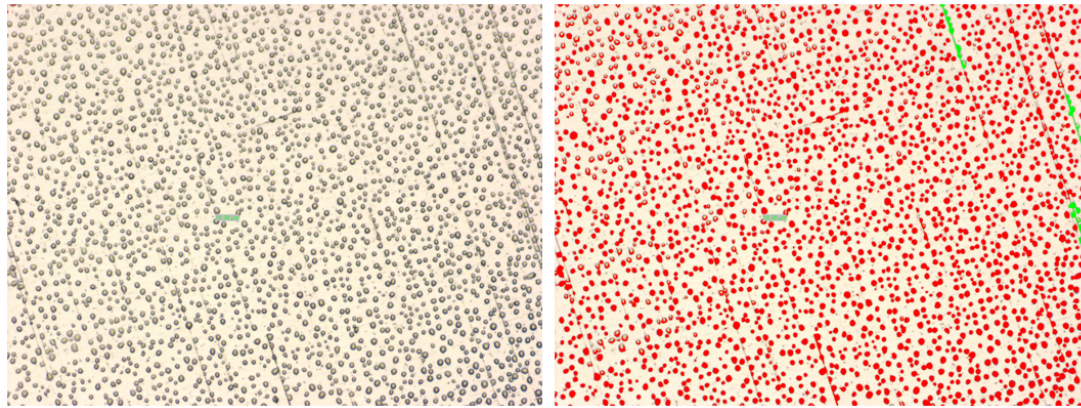
Figure 4. Fog particle analysis at × 50 zoom.